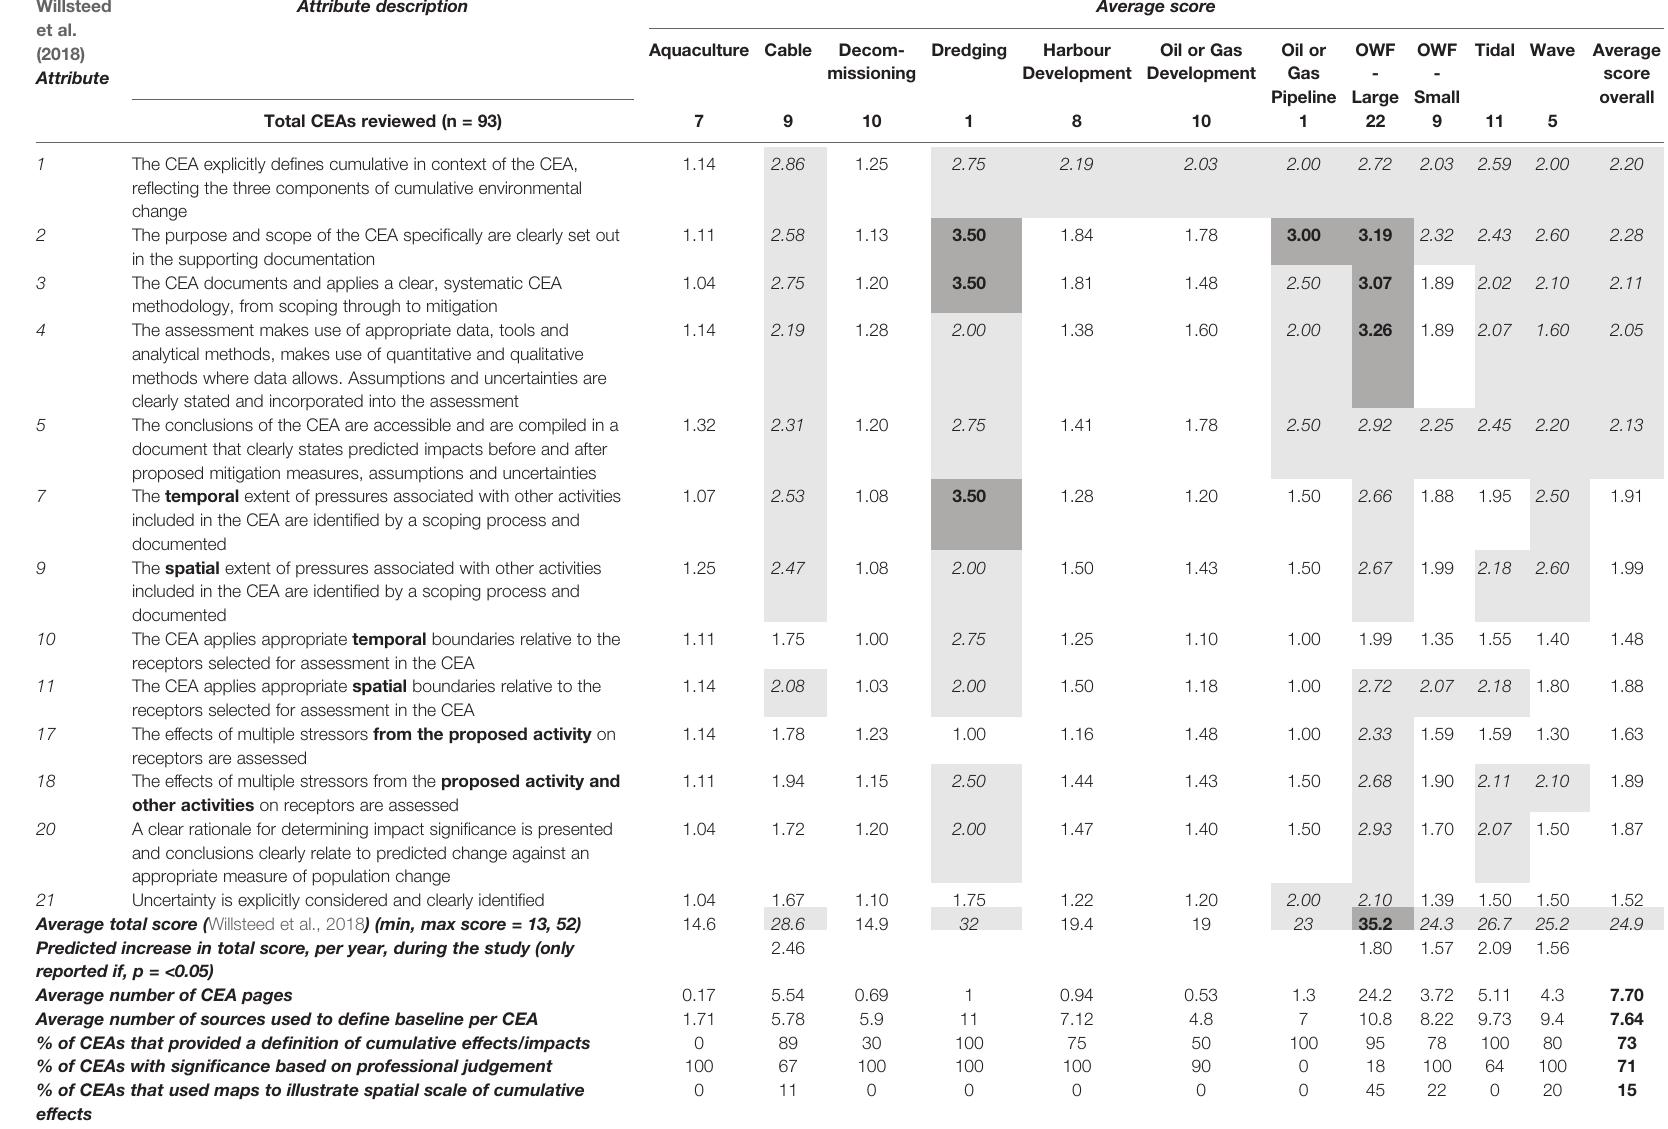
TABLE 1 | Average score for the thirteen attributes used to grade each Cumulative Effects Assessment (CEA), by industry (from Willsteed et al., 2018). Willsteed et